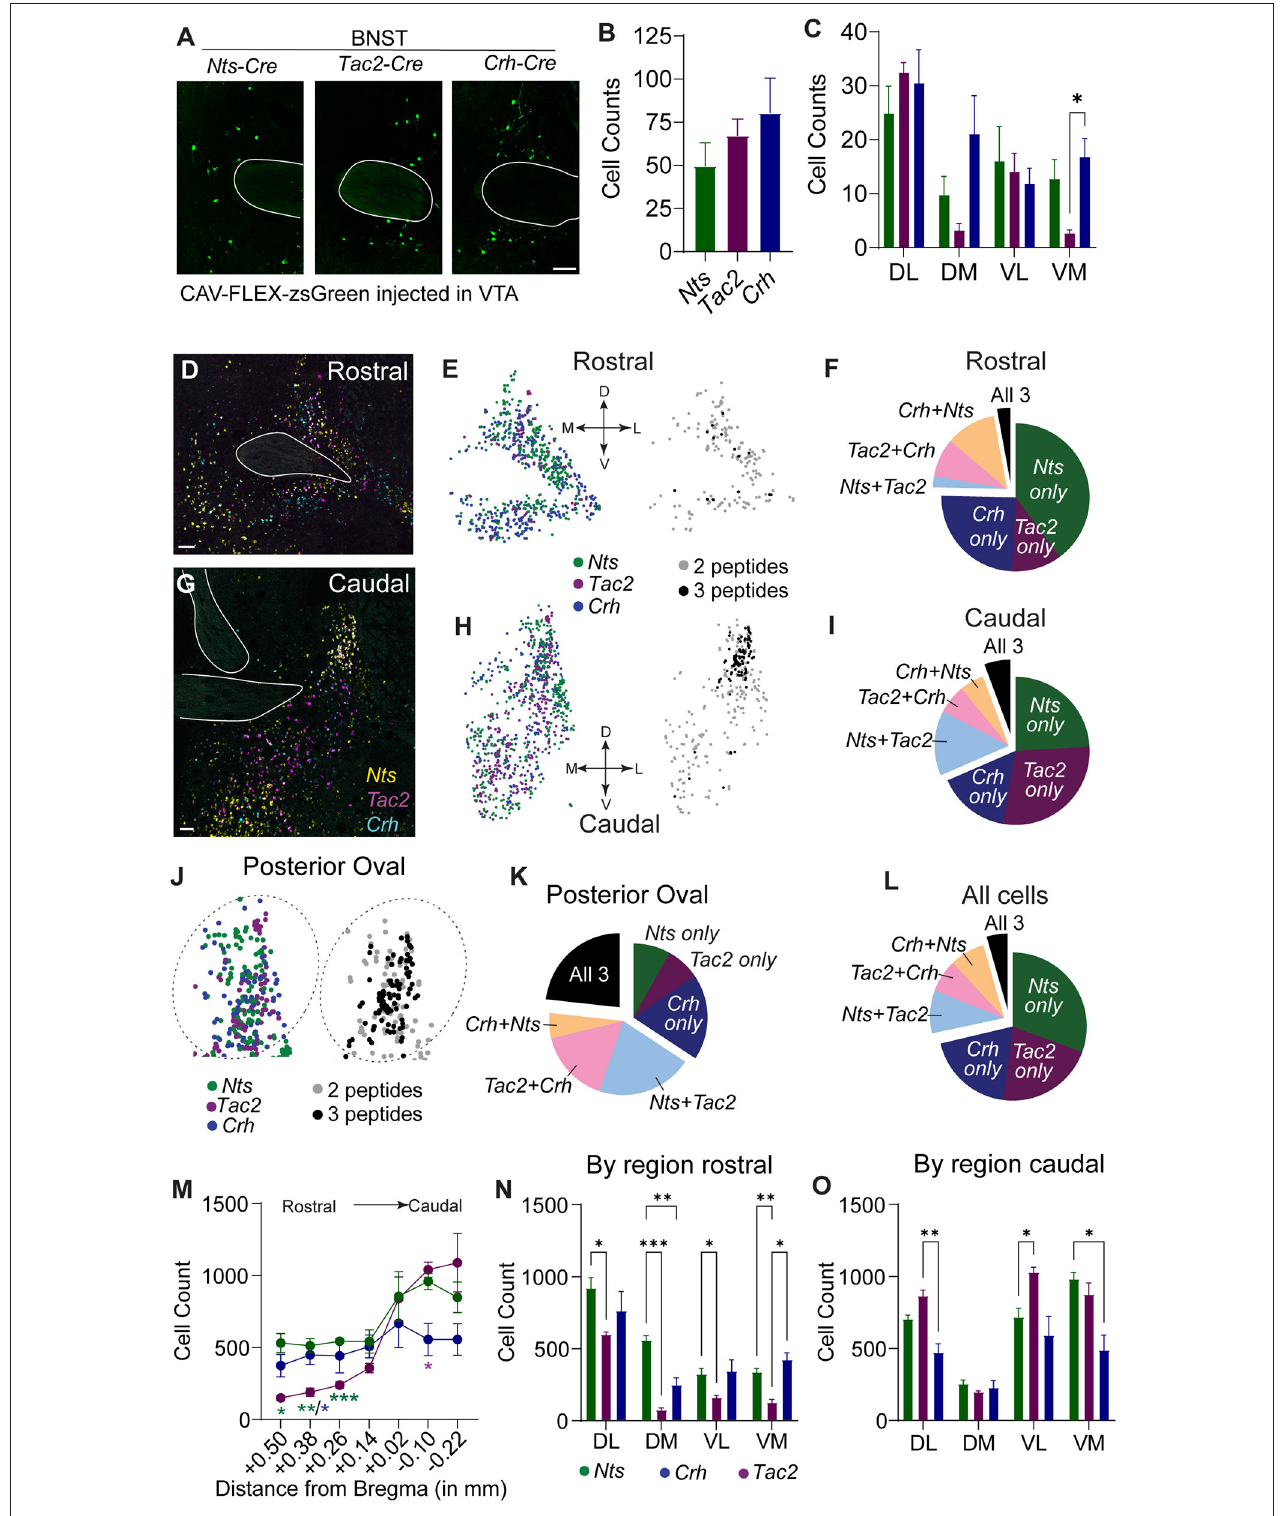
FIGURE 2 | Spatial distribution of Nts, Tac2, and Crh expression in the BNST. (A) Example images showing zsGreen retrogradely labeled Nts , Tac2 , and Crh neurons in the BNST. Scale bar = 100 µ m. (B) Total number of retrogradely labeled cells in the BNST in each Cre line ( n = 5 Nts, 5 Tac2, and 6 Crh mice). (C) Distribution of retrogradely labeled cells in the dorsolateral, dorsomedial, ventrolateral, and ventromedial BNST [2 way RM ANOVA, effect of Cre line: F (2,14) = 4.181, P = 0.0377,